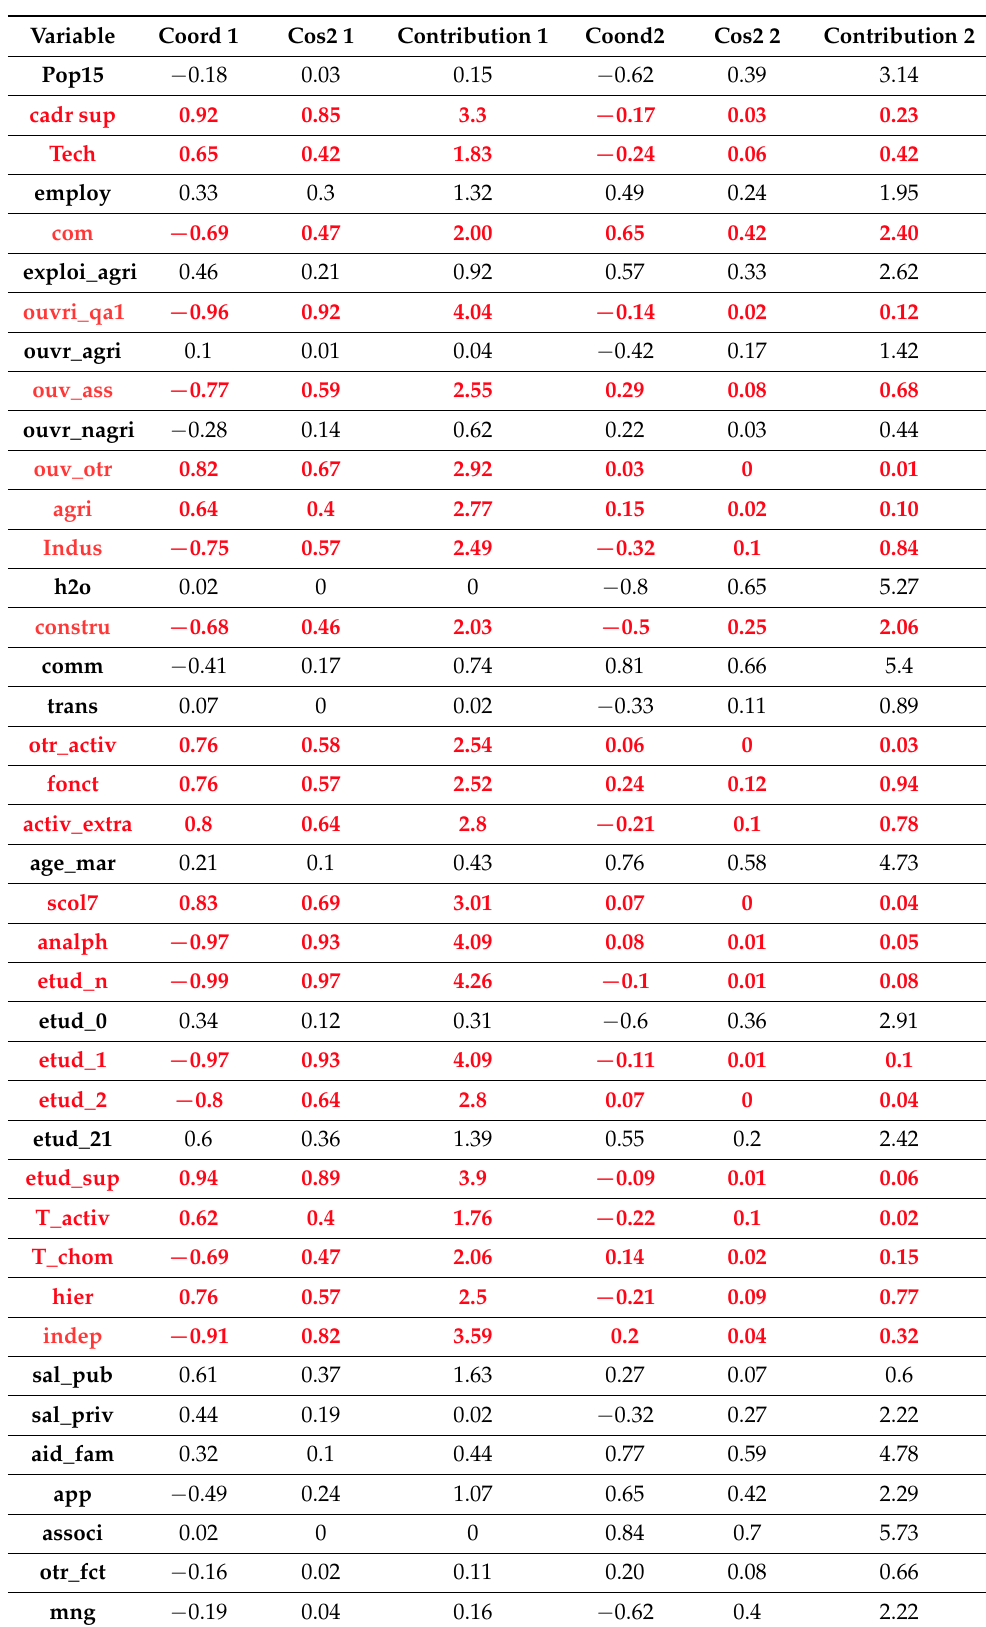
Table 1. Summary of the two first